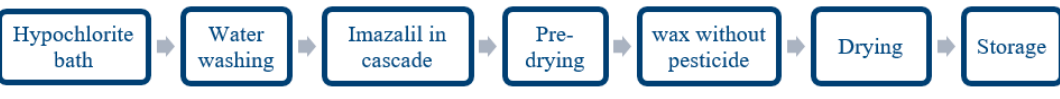
Figure 2. Packing-line pesticide application scheme (postharvest step).